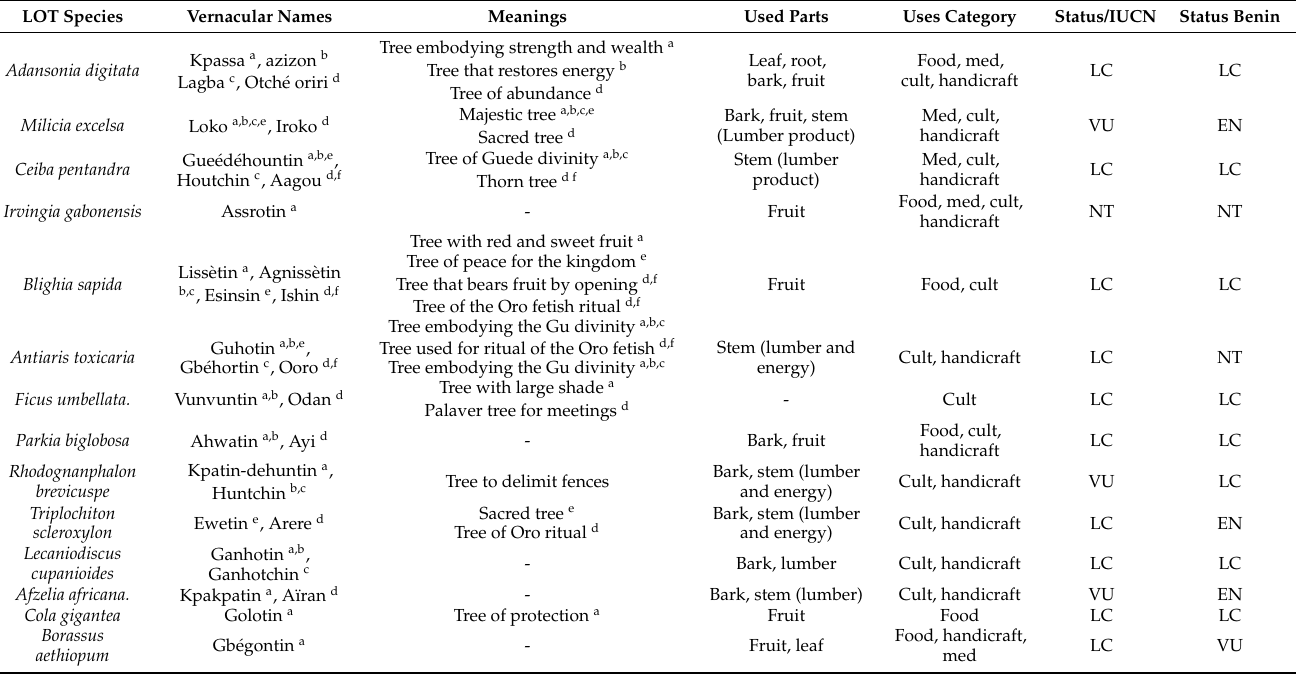
Table 5. Meaning of the vernacular names of the inventoried LOTs.